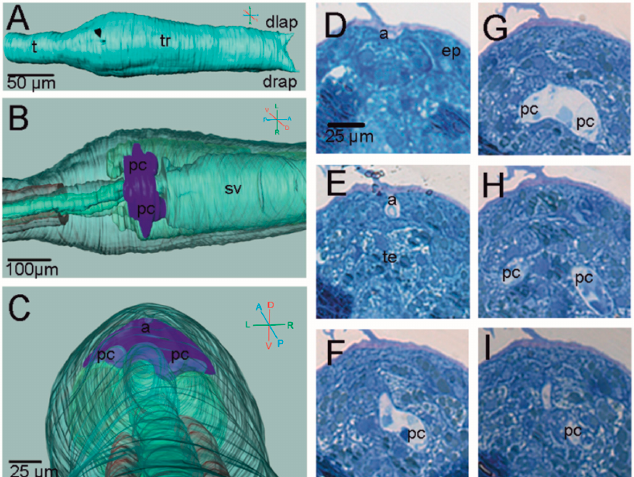
Figure 2. Atrial chamber in H. roretzi. See Figure 1 for colour code and abbreviations. ( A – C ) Three- dimensional reconstruction. In B,C the organs are transparent. ( A ) Dorsal external view showing the dint in correspondence of the atrial siphon (arrowhead). ( B ) Dorsal view. ( C ) Frontal-posterior view enlightening the position of the atrial chamber relative to the notochord. ( D – I ) Serial cross histological sections from anterior to posterior at the level of the atrial and peribranchial chambers. Toluidine blue. The enlargement is the same in ( D – I ). In Figure 3, the 3D reconstructions of three ascidian larvae are compared: H. roretzi (solitary, stolidobranch; Figure 3A,B), Botryllus schlosseri (colonial, stolidobranch; Figure 3C,D) and Ciona intestinalis (solitary, phlebobranch; Figure 3E,F).